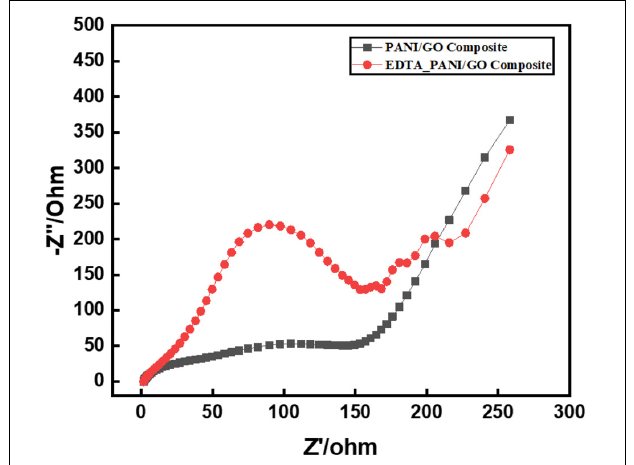
FIGURE 4 | EIS Nyquist plots of PANI/GO composite and EDTA modified PANI/GO composite electrodes in 0.5 M H 2 SO 4 electrolyte.